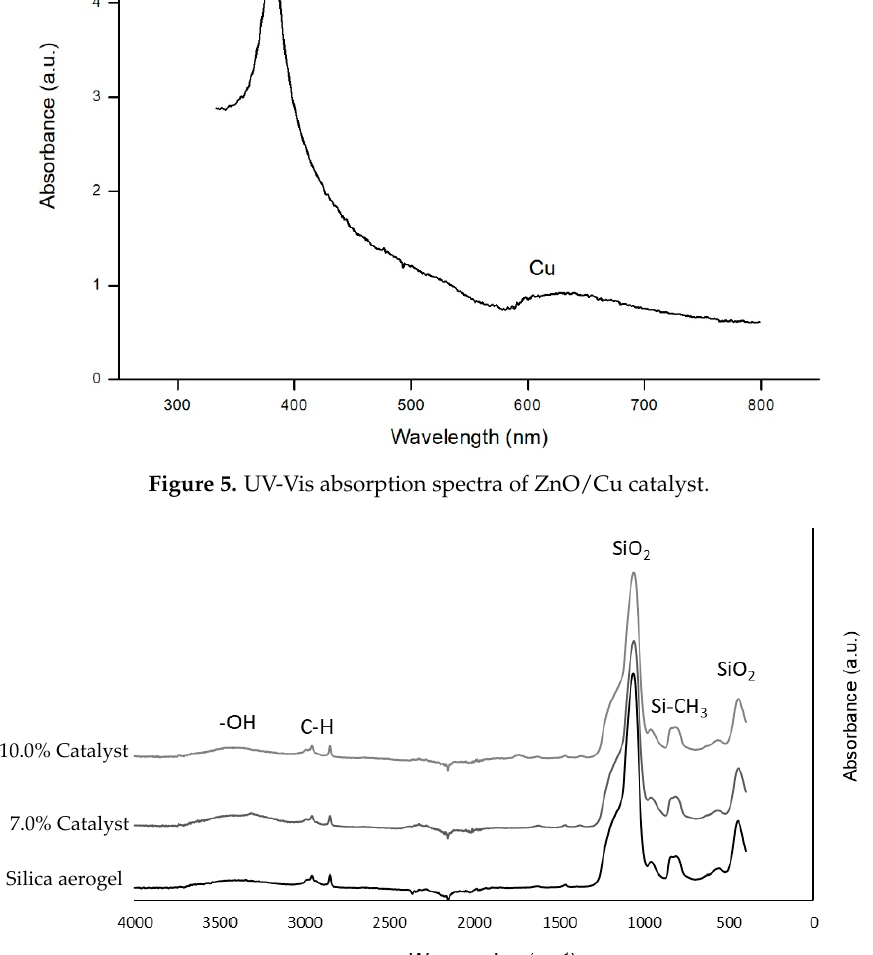
Figure 6. FTIR spectra of silica aerogel without and with catalyst load.